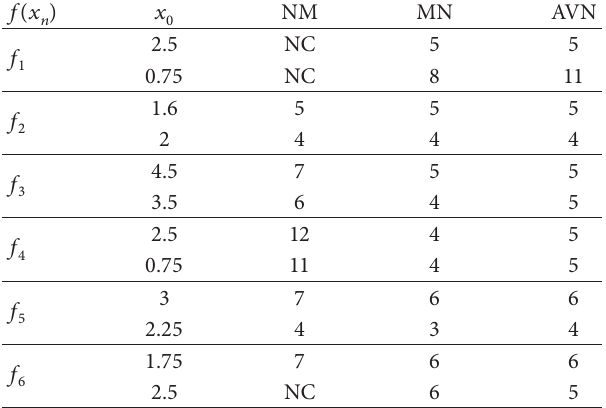
Table 2: NM represents ordinary Newton-Raphson iterations, MN represents multiplicative Newton-Raphson iterations, and AVN represents alternative Volterra Newton-Raphson iterations. 𝑥 0 rep- resent initial value. NC states that the given method does not converge for the given zero of function 𝑥 𝑒